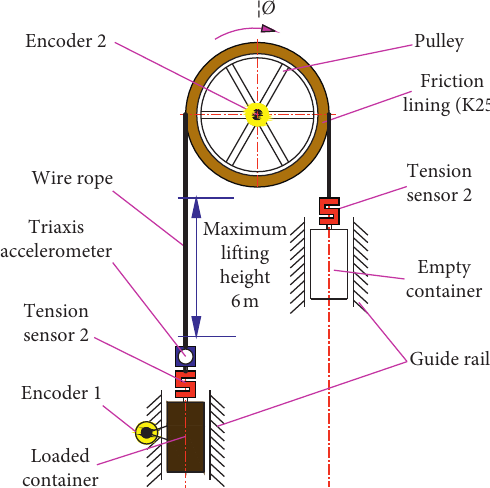
Figure 2: Schematic diagram of the dynamic friction transmission experiment device of the friction hoist.